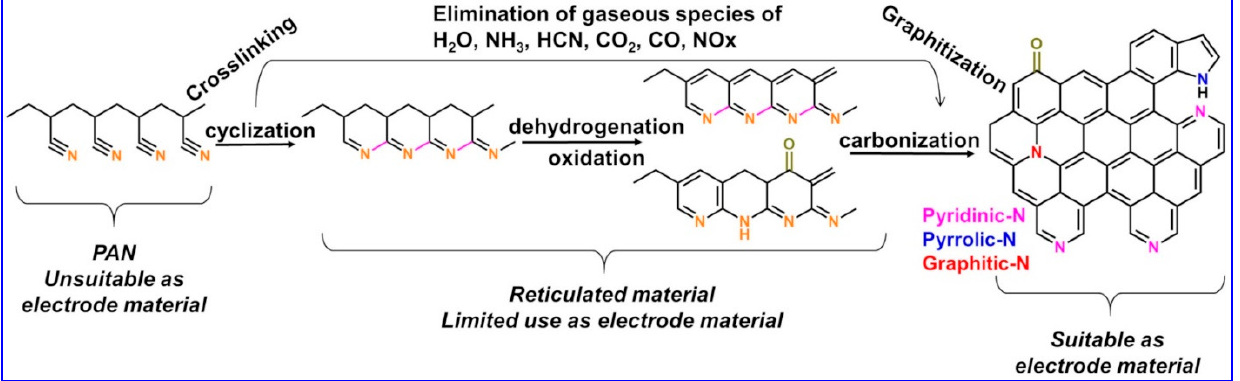
Figure 4. Sketch of the thermal treatment starting from polyacrylonitrile-based material to the fabrication of an electrode